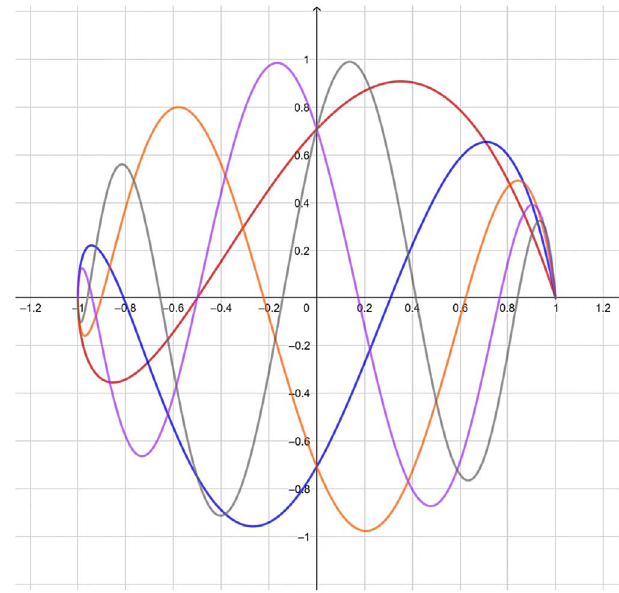
Figure 11. W k +1/2 ( x ), k = 1, 2, 3, 4, 5. (1) Red; (2) blue; (3) orange; (4) violet; (5)